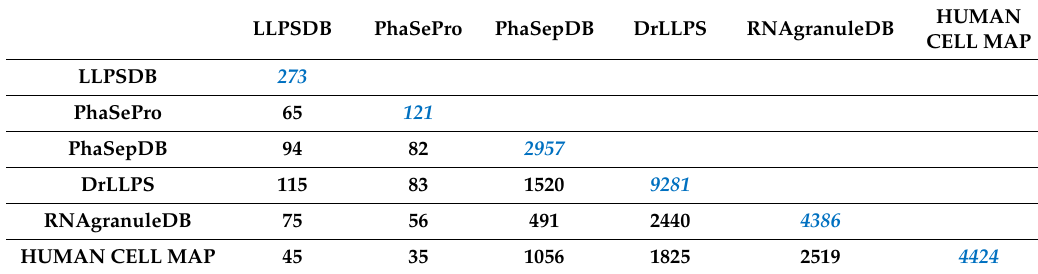
Table 2. Overlapped protein numbers between the six databases related to LLPS. (The numbers of overlapped proteins between any two databases were obtained though “UniProt ID” except for RNAgranuleDB. For the overlapped proteins between RNAgranuleDB and other databases, “gene name” was used for comparison. The diagonal blue number shows the number of proteins deposited in each database (for DrLLPS, the potential orthologs were not included), which is somehow slightly di ff erent from that reported in the corresponding paper for PhaSepDB, DrLLPS, and RNAgranuleDB, probably due to correction after the databases’